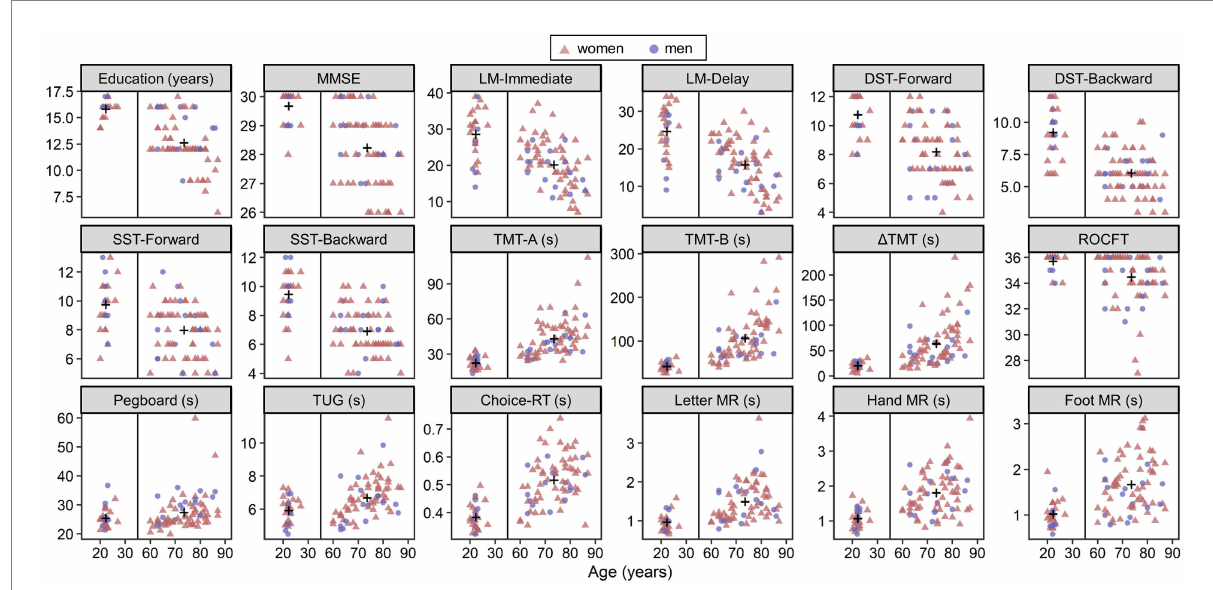
FIGURE 2 Scatterplots of all indexes as a function of age. The plus signs in panels show group means. LM, logical memory; DST, digit span test; SST, spatial span test; TMT, trail making test; ROCFT, the copy condition of Rey–Osterreich complex figure test; TUG, timed up and go test; RT, reaction time; MR, mental rotation.